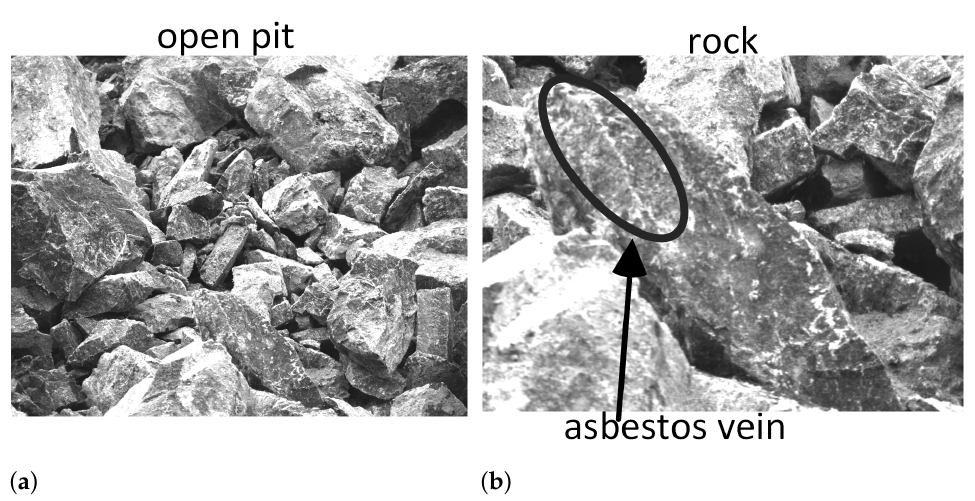
Figure 1. Typical photos of an open pit ( a ), rock, and asbestos veins there ( b